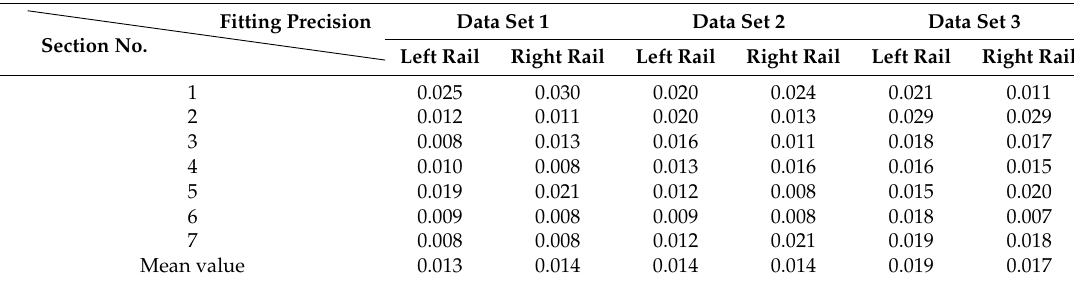
Table 2. Precision of clearance coordinate system (Unit: m).